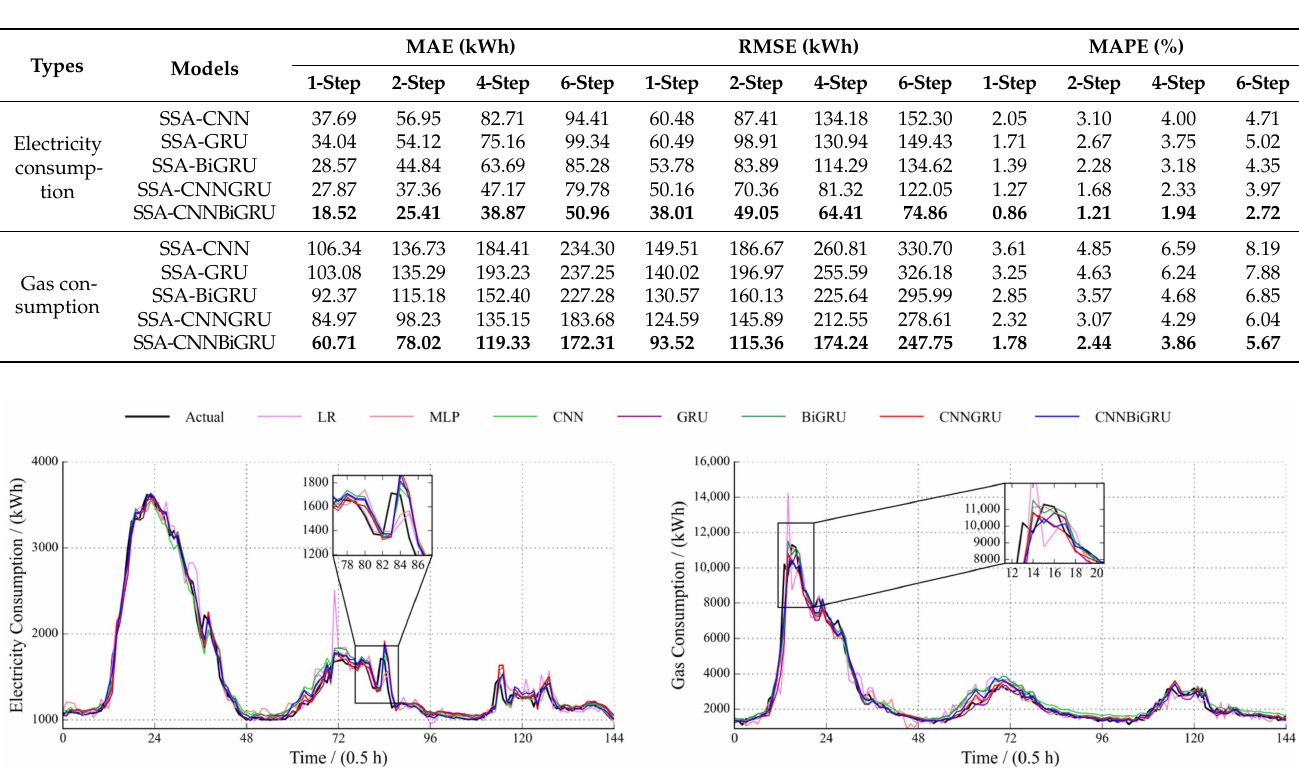
Table 5. Prediction error evaluation indicators of different deep neural networks based on the SSA method.